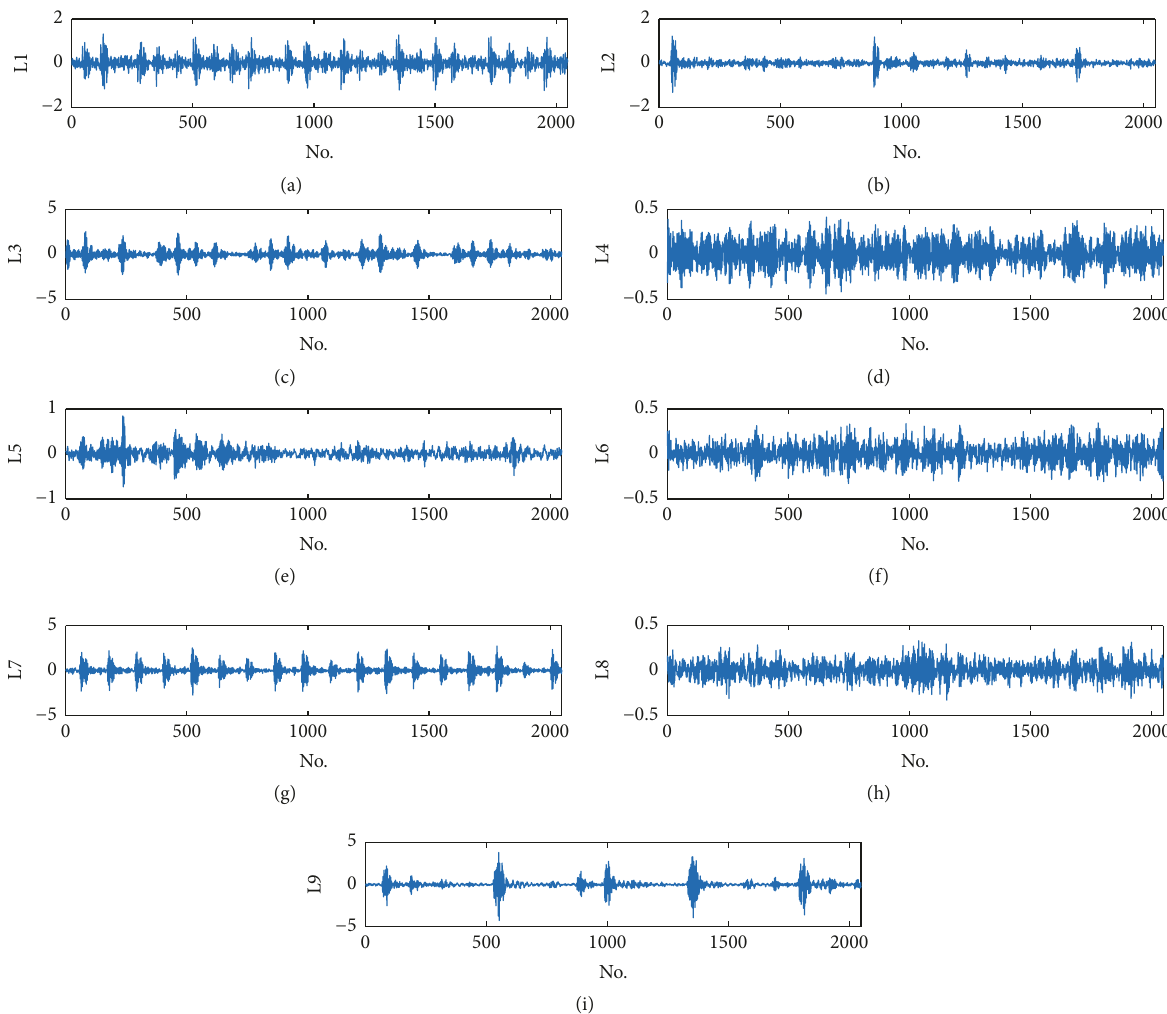
Figure 2: Experiment stand and its measurement sensors in bearing data center.